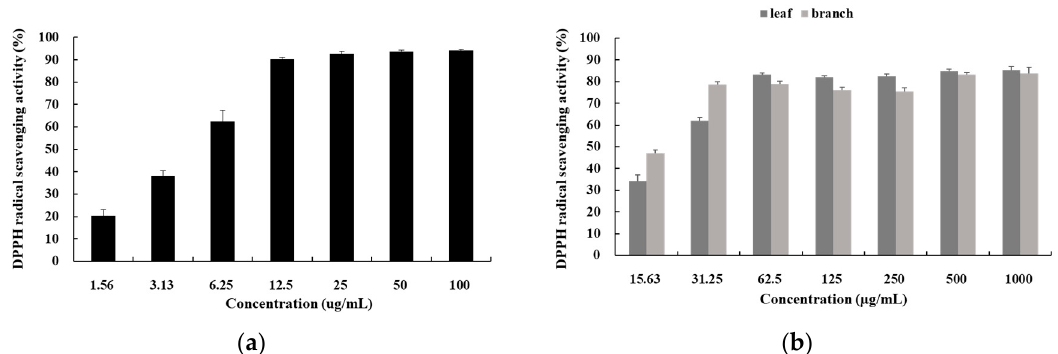
Figure 1. DPPH (2,2-diphenyl-1-picrylhydrazyl) radical scavenging activities of ( a ) L-ascorbic acid and ( b ) hot-water extracts of the S. samarangense . An appropriate amount of ascorbic acid was used as a positive control. The results were expressed as the mean ± SD of data obtained from three independent